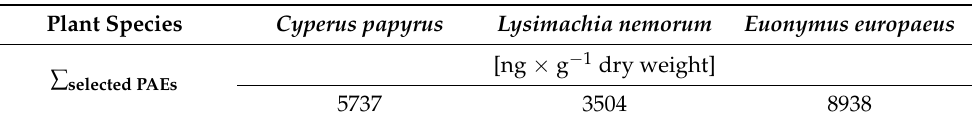
Table 6. The sum of the uptake of selected phthalates in ng × g − 1 dry weight by tested plant species growing in an MWWTP. Plant Species Cyperus papyrus Lysimachia nemorum Euonymus